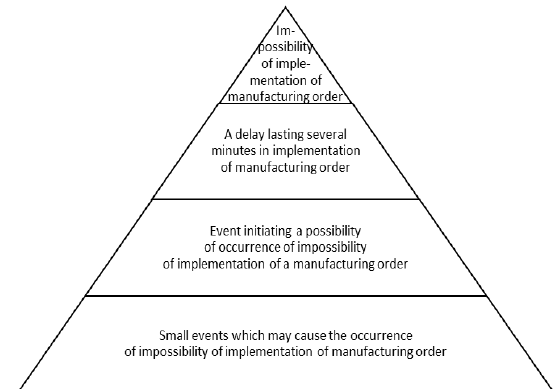
Figure 3: Pyramid of events of impossibility of implementation of an order Source: B. Eskhardt [28]